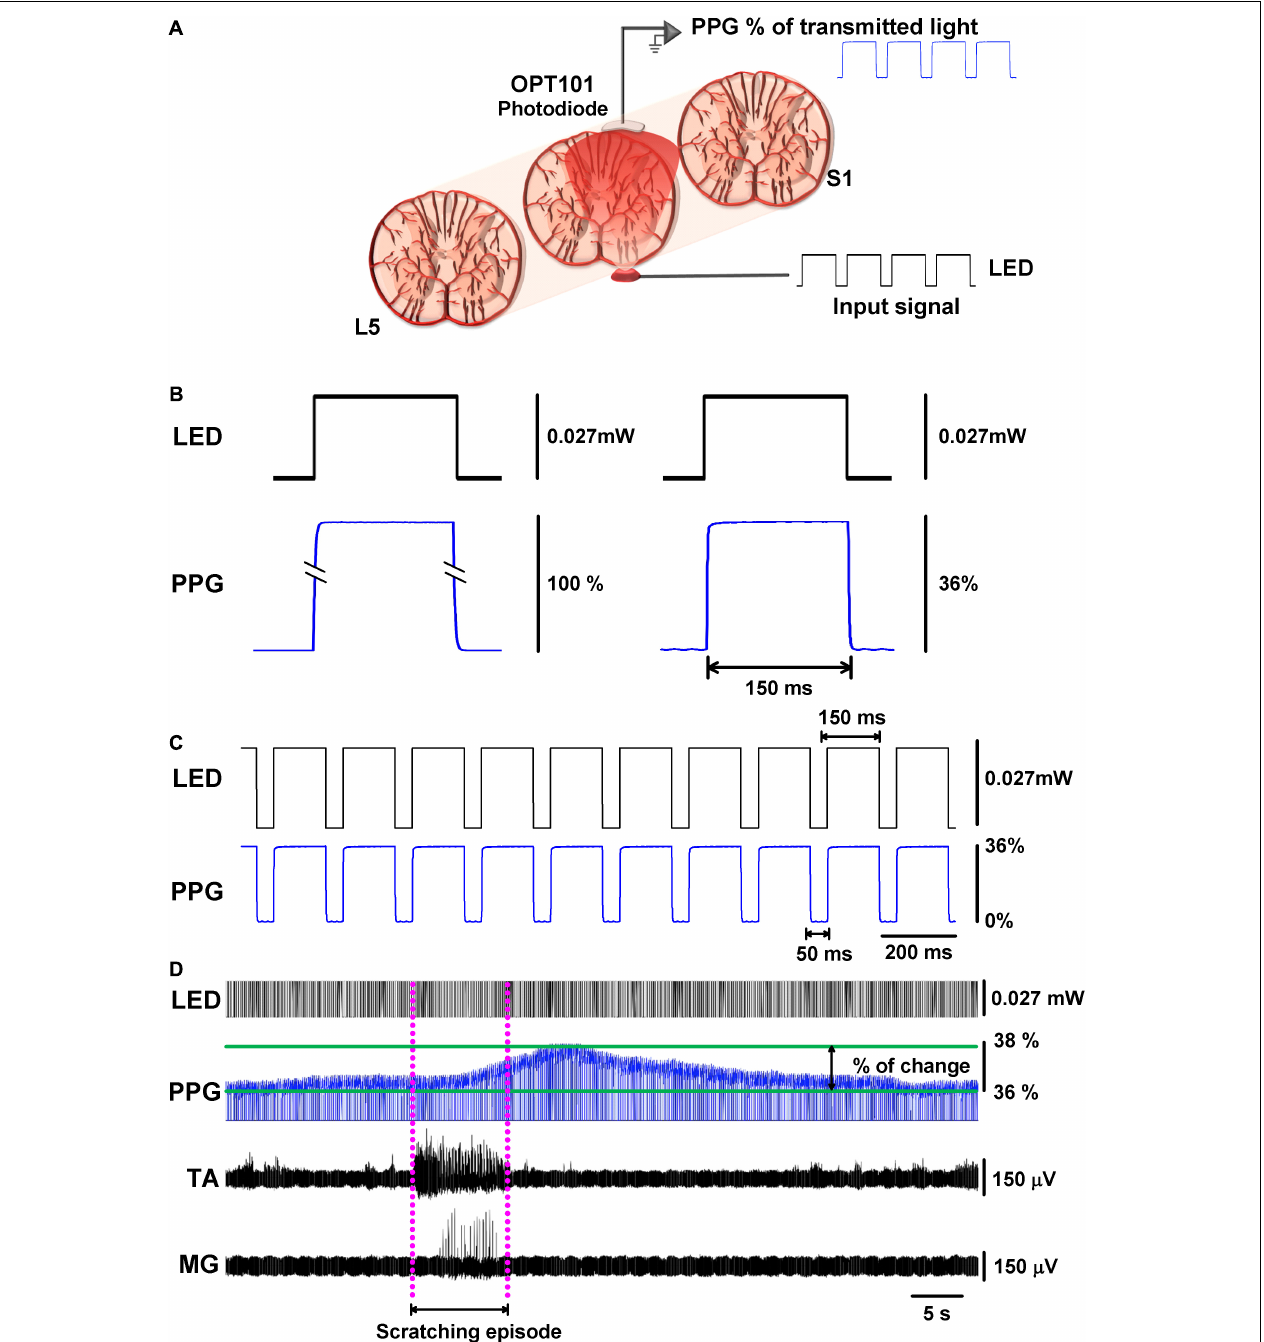
FIGURE 1 | Functional DC-PPG applied to the cat spinal cord during an episode of motor activity. (A) Scheme of the experimental arrangement, illustrating a red LED below the L6 lumbar spinal segment, and a Texas Instruments OPT-101 photodiode on the spinal cord. The dura mater was removed to allow that both devices could touch, but not press the spinal cord. (B) Comparison between the DC-PPG response to LED illumination, with and without the spinal cord. Without any tissue in between, the photodiode detects 100% of the red light (left panel). Note how a LED pulse produces attenuation from 100% to about 36% of the red light when it crosses the spinal cord (right panel). (C) Upper panel, a train of red-LED pulses of 150 ms with a dark interval of 50 ms and an amplitude of 0.027 mW of light intensity applied throughout the spinal cord, as illustrated in panel (A) . (C) Lower panel, the OPT-101 photodiode response in the spinal cord (i.e., a zoom in of the pulsed elements of the functional DC-PPG signal); note that the spinal cord tissue attenuated the light to 36%. (D) Typical recording in real-time of the functional DC-PPG signal in the spinal cord elicited during an episode of motor action (fictive scratching). Note: how the tibialis anterior (TA) and medial gastrocnemius (MG) nerve activities precede by few seconds the maximal peak response of the functional DC-PPG signal detected with the OPT-101 photodiode. The dashed pink lines illustrate the length of the fictive scratching episode (i.e., the motor activity episode).